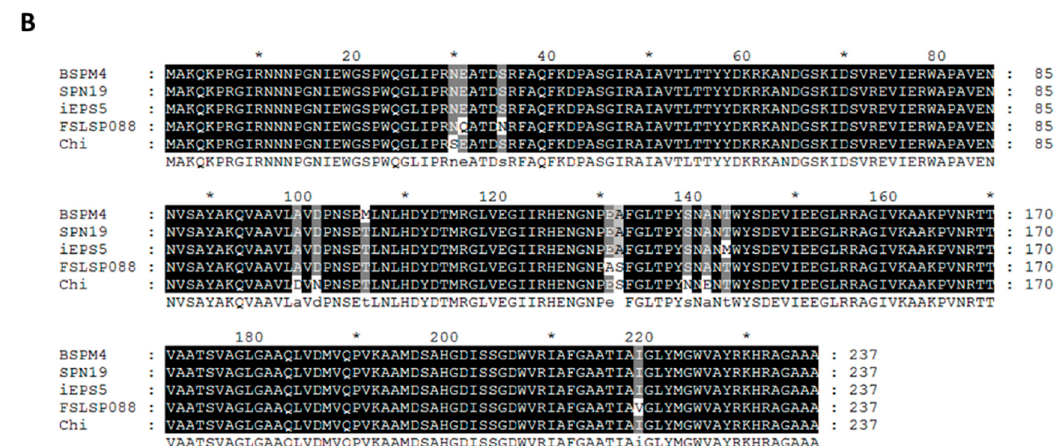
Figure 6. Amino acid sequence alignments of M4Lys with other endolysins. ( A ) Phylogenetic analysis of endolysins from Gram-negative bacteria phages. Each group corresponds to a different functional domain: group I, V superfamily; group II, D-alanyl-D-alanine-carboxypeptidase; group III, N -acetyl muramoyl L-alanine amidase; group IV, glycoside hydrolase family 19; group V, N -acetylmuramidase; and group VI, glycoside hydrolase family 24, respectively; ( B ) Amino acid sequence alignments of the M4Lys protein of phage BSPM4 with other putative lysis proteins of relevant phages including SPN19, iEPS5, FSLSP088, and Chi. Conserved and identical residues are shaded in gray and black, respectively.